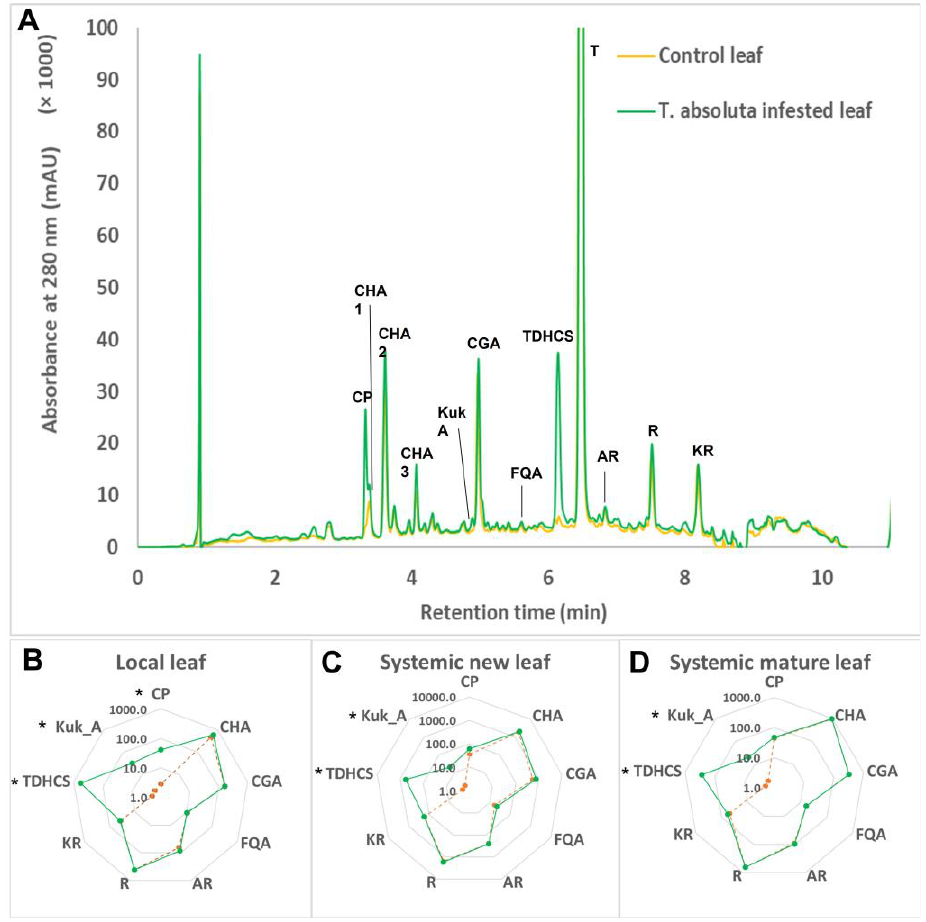
Figure 2. Impact of T. absoluta herbivory on the phenolic composition of tomato leaf. ( A ) Chromatogram at 280 nm of tomato local leaf extracts with and without infestation with T. absoluta . The phenolic compounds have been identified according to Larbat et al., 2014 [37]. CP, caffeoylputrescine; CHA1-3, caffeoylhexaric acid isomers 1 to 3; CGA, chlorogenic acid; FQA, feruloylquinic acid; TDHCS, N 1 ,N 5 ,N 14 -tris ( dihydrocaffeoyl ) spermine; Kuk_A, kukoamine A; AR, apio-furanosyl rutine; R, rutine; KR, kaempferol rutinoside. Taxifoline (T) was used as an internal standard ( B – D ). Concentrations (µg/g dry weight) of the phenolic compounds identified in leaves infested with T. absoluta larvae ( B , local leaf), in leaves above the leaf range infested with T. absoluta larvae ( C , systemic new leaf) and in leaves below the leaves infested with T. absoluta ( D , systemic mature leaf). Values are the means of six replicates. Asterisks (*) indicate metabolites with concentrations significantly different between healthy and T. absoluta -infested tomato ( p < 0.05).